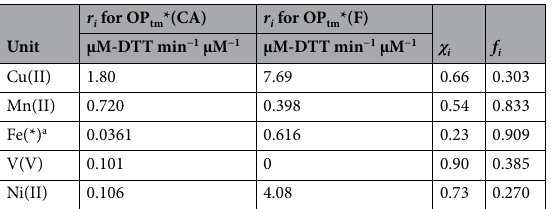
Table 2. Values assumed for the parameters of Eq. (2) to estimate OP tm *(CA) and OP tm *(F). a Assuming the equal presence of Fe(II) and Fe(III).